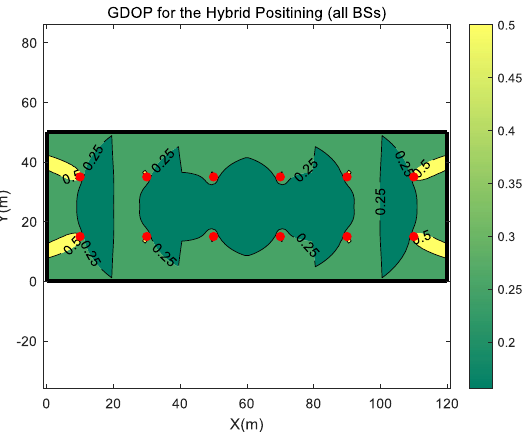
Figure 6. GDOP of the hybrid positioning when all BSs are used for positioning. The red dots indicate